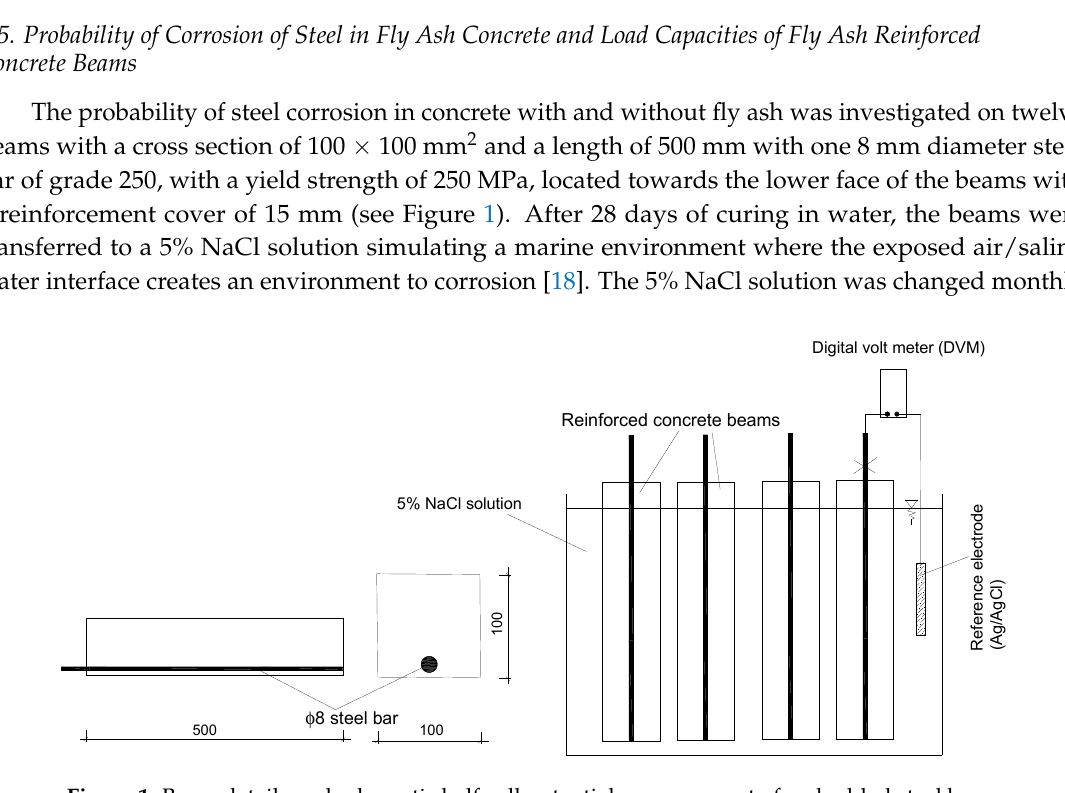
Figure 1. Beam details and schematic half-cell potential measurement of embedded steel bars.